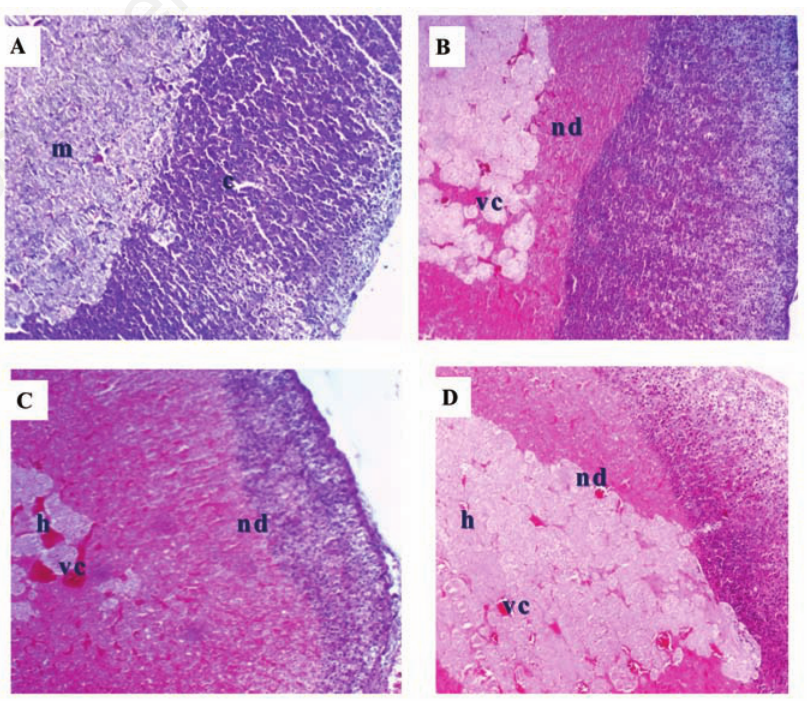
Figure 5. Photomicrographs of adrenal glands from control rats (A), showing normal cortex (c) and medulla (m), and from rats given lambda-cyhalothrin at the dose of 20.4 mg/kg (B), 30.6 mg/kg (C) or (D) 61.2 mg/kg (D), showing extensive necrotic degener- ation (nd) of the adrenal cortex, vascular congestion (vc) and areas of hemorrhage (h) (hematoxylin and eosin